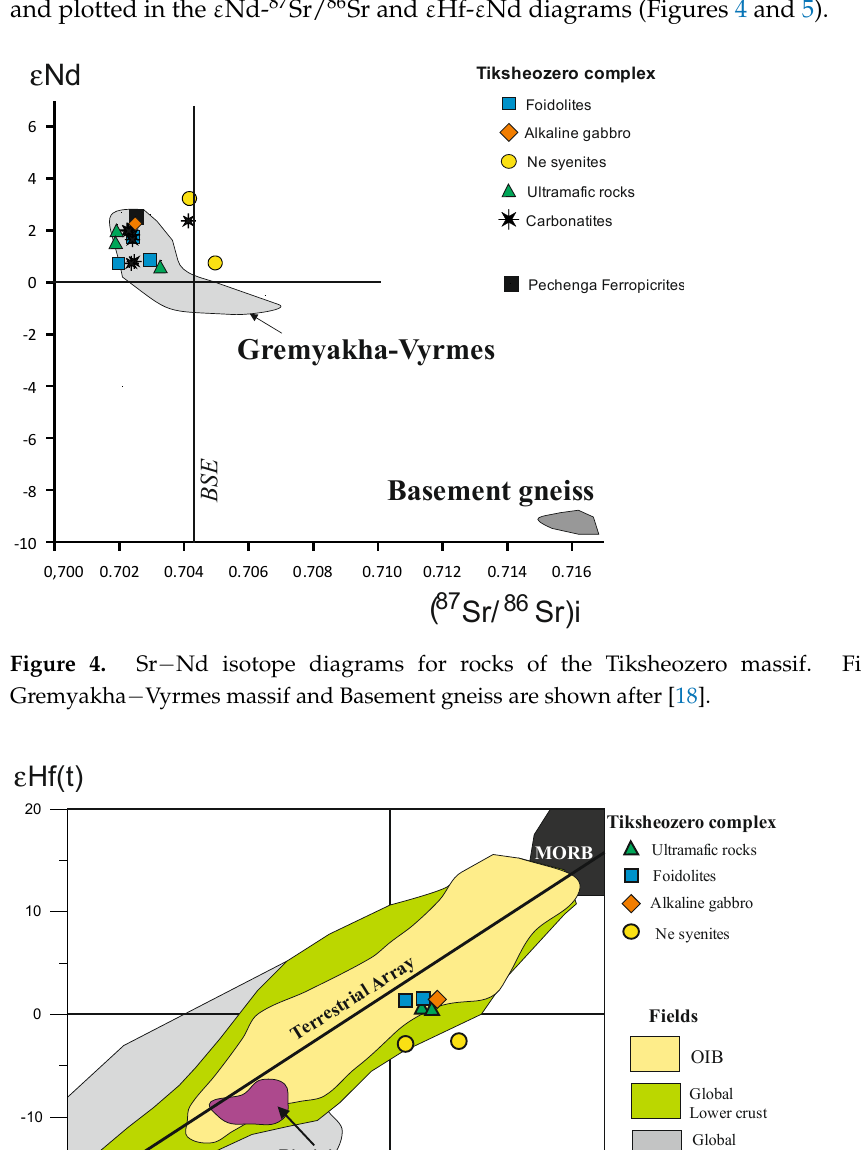
Table 3. Whole rock Re-Os and Lu-Hf isotopic data on the Tiksheozero complex.